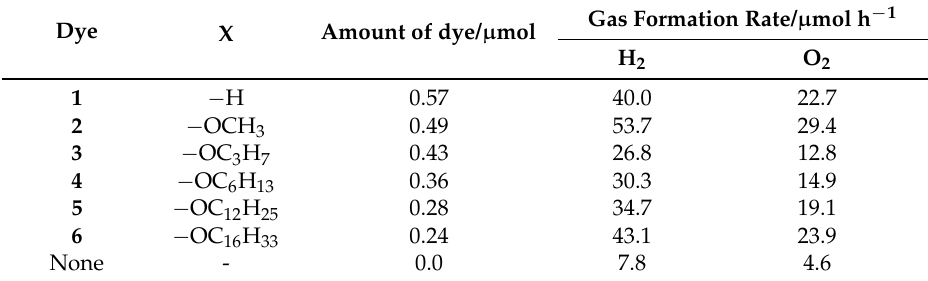
Table 1. Photocatalytic activity of porphyrin-modified KTa(Zr)O 3 for water splitting 1